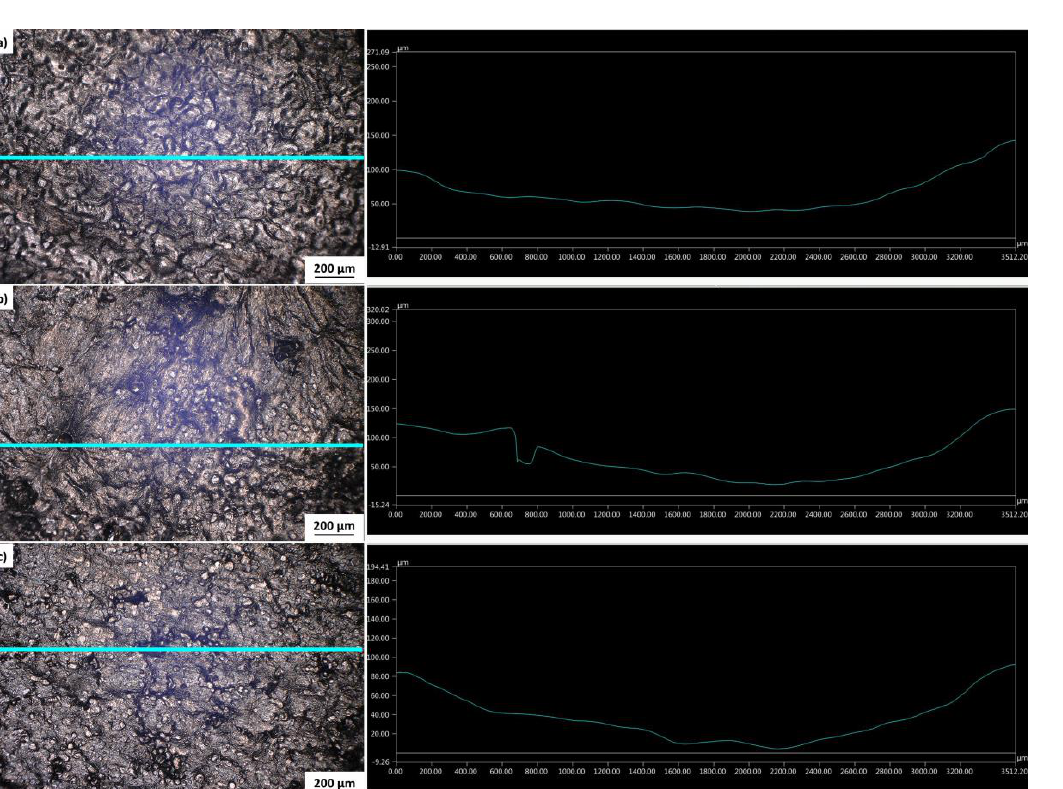
Figure 6. The re-solidified structure of the clad material after brazing, ( a ) Sample A, ( b ) Sample B, ( c ) Sample C.